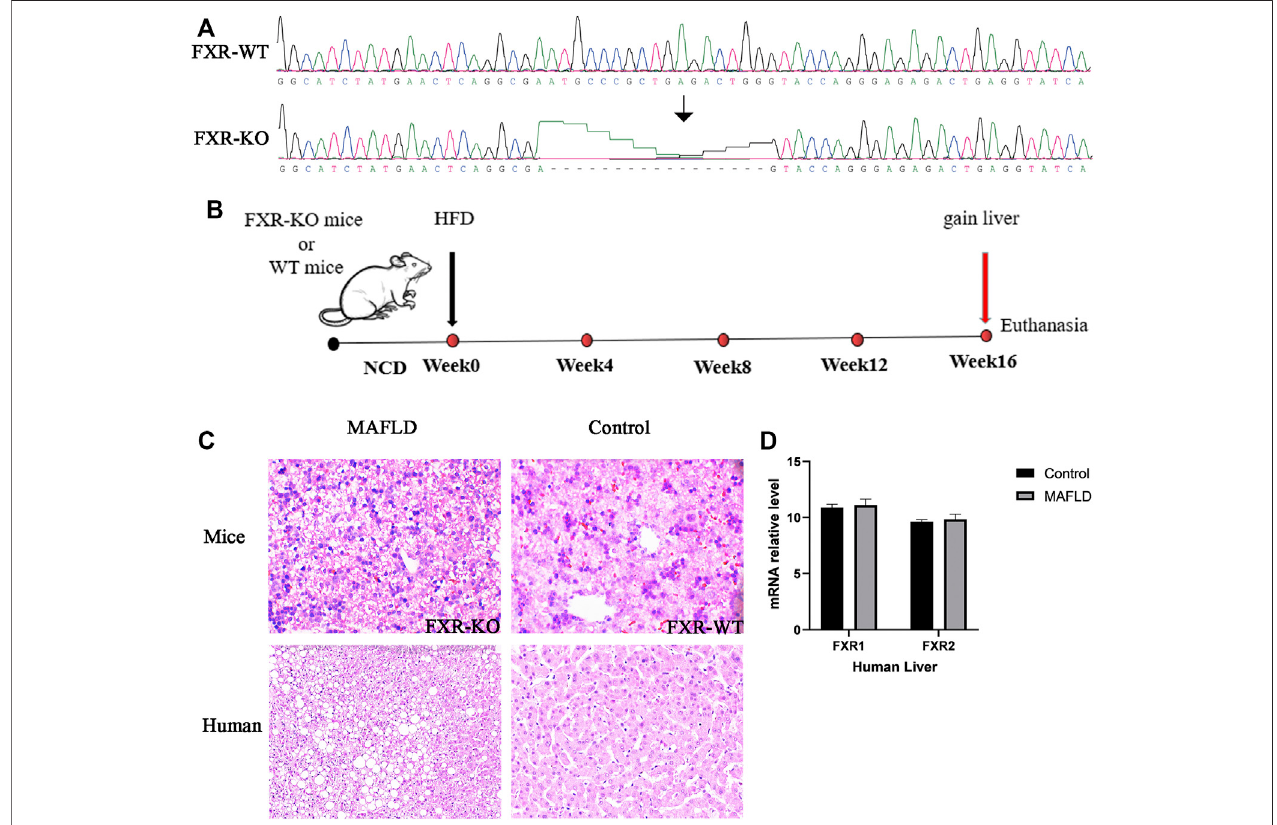
FIGURE 1 | FXR is downregulated in the livers of MAFLD mice and is associated with increased lipid accumulation in the liver. (A) The result of gene sequencing in theliverofMAFLDmiceandcontrols. (B) Schematicrepresentationoftheexperimentaldesign. (C) Paraf fi n-embeddedliversectionsstainedwithH&E. (D) Relativelevels of FXR mRNA detected in the liver of MAFLD patients and